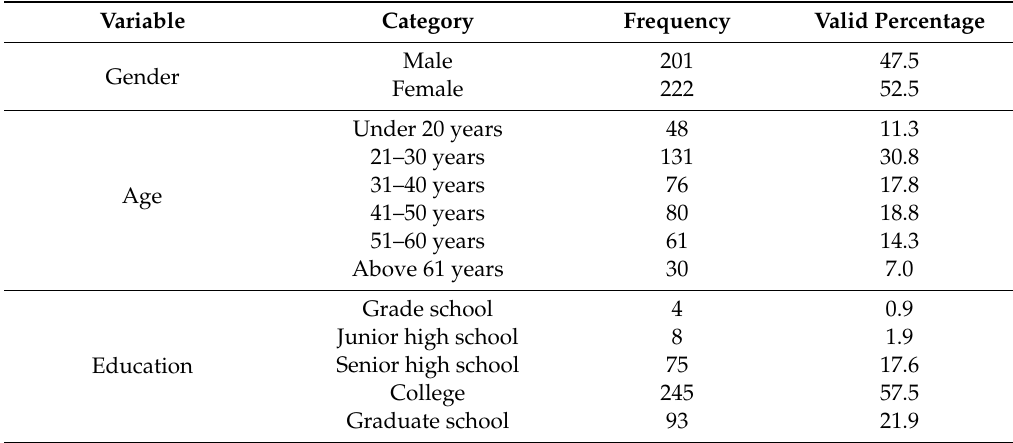
Table 1. Respondent